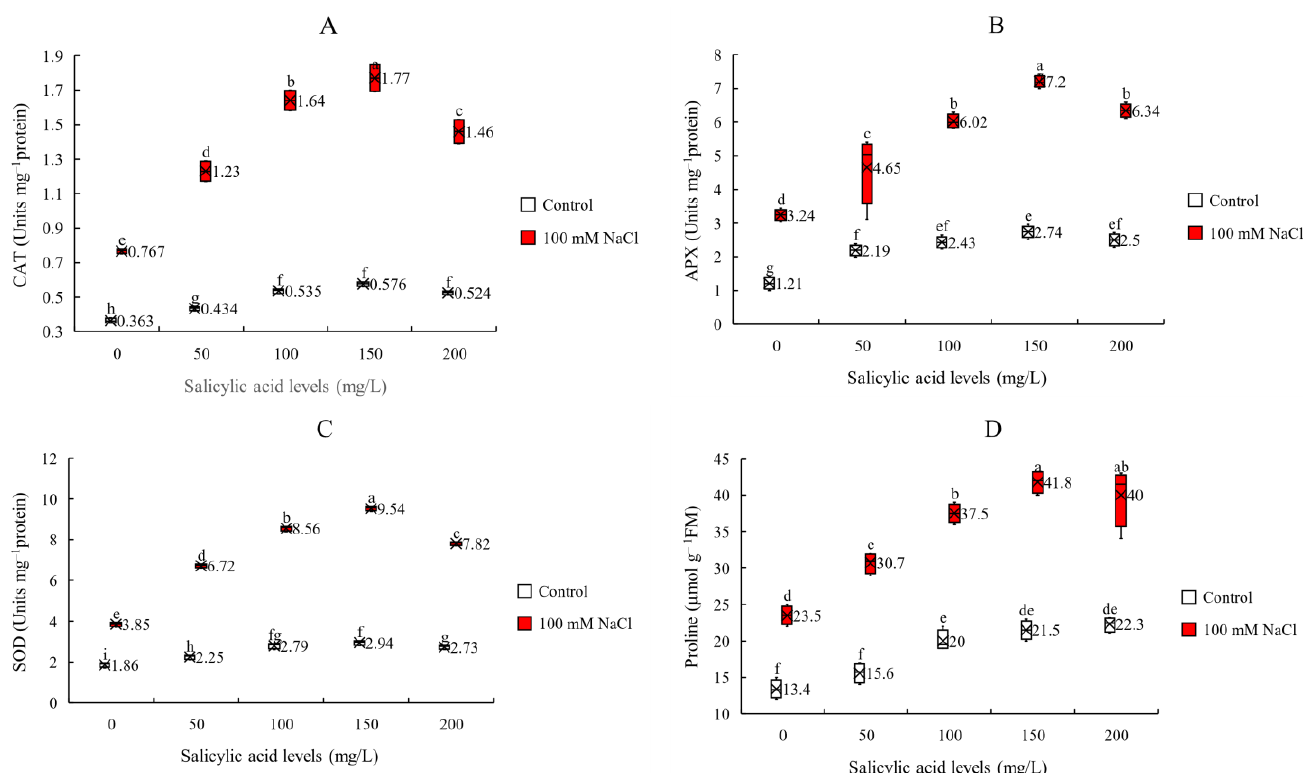
Figure 4. Specific activity of antioxidative enzymes ( A ) catalase (CAT), ( B ) ascorbate peroxidase (APX), and ( C ) superoxide dismutase (SOD) and ( D ) proline content (P) of sorghum plants for interaction of SA treatments × salinity (100 mM NaCl) in four repetitions at fifty percent flowering stage. Different letters indicate significant differences by HSD at p < 0.05. The data for analysis are given in Table S1.